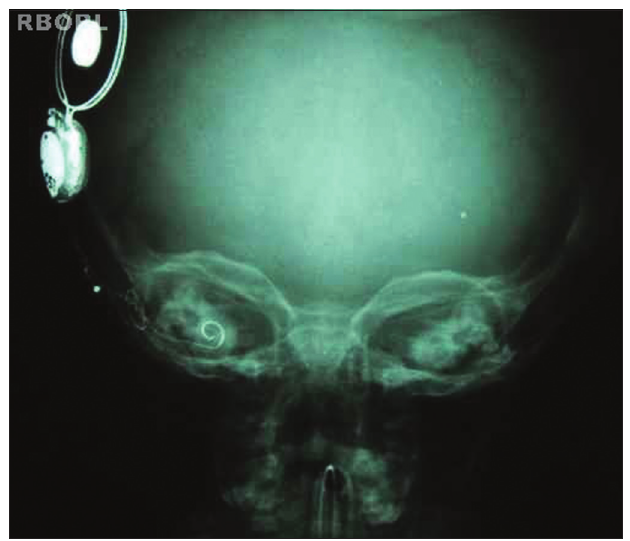
Figura 3. Resultado radiológico esperado (AP